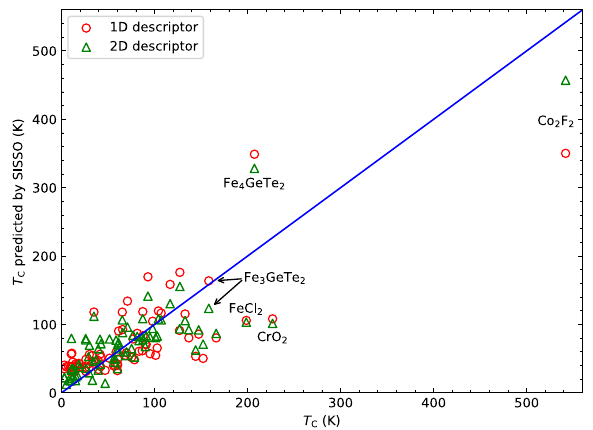
Fig. 4 The T C predicted by SISSO vs. the T C calculated via the high-throughput fi rst-principles calculations. The red circles are the results of 1D descriptor, whereas the green triangles are the results of 2D